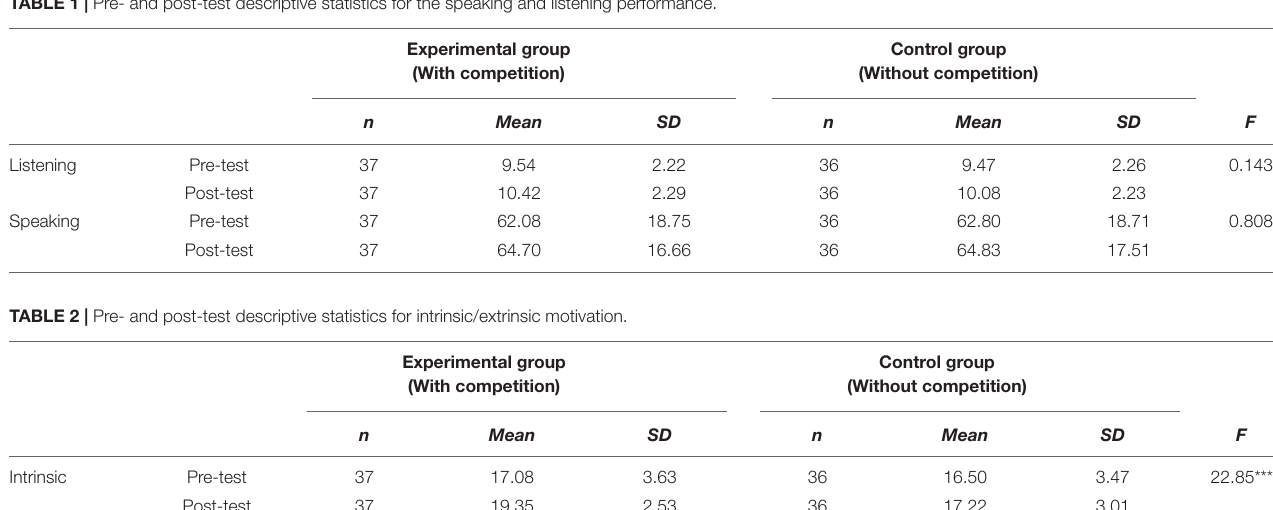
TABLE 1 | Pre- and post-test descriptive statistics for the speaking and listening performance.